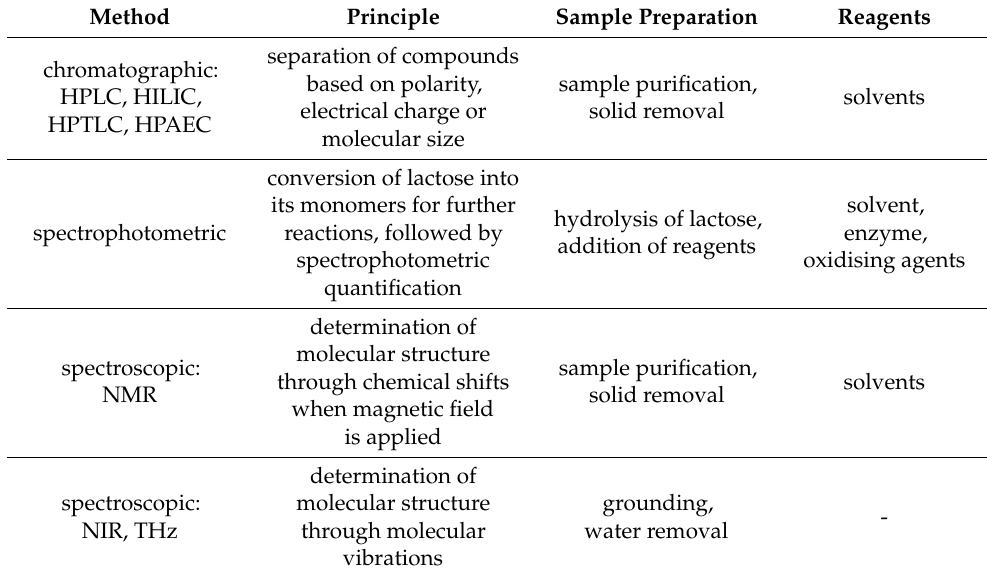
Table 1. Comparison of common analytical methods for lactose